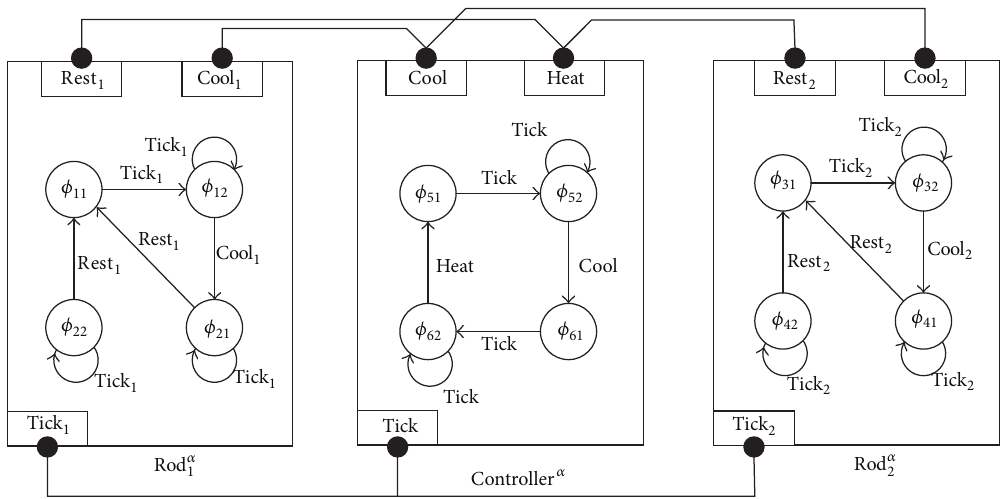
Figure 5: The abstraction for the component-based